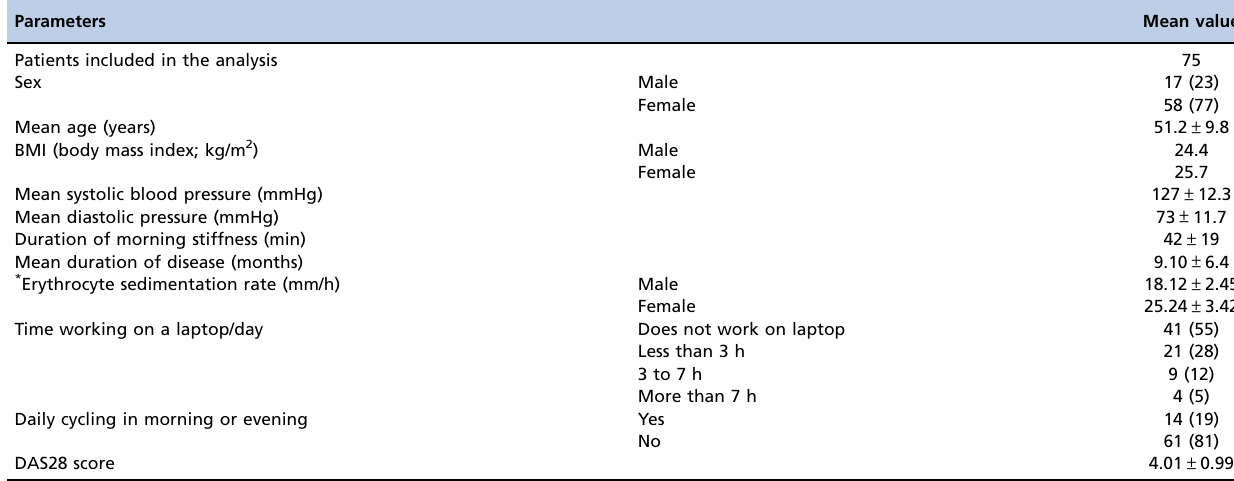
Table 2 - Anthropologic, social, demographic and clinical characteristics of the enrolled patients.